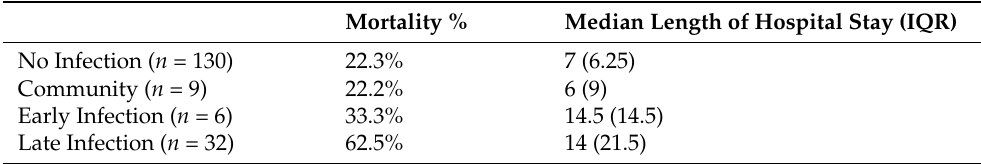
Table 2. Outcomes of patients according to their infection timing-related group.